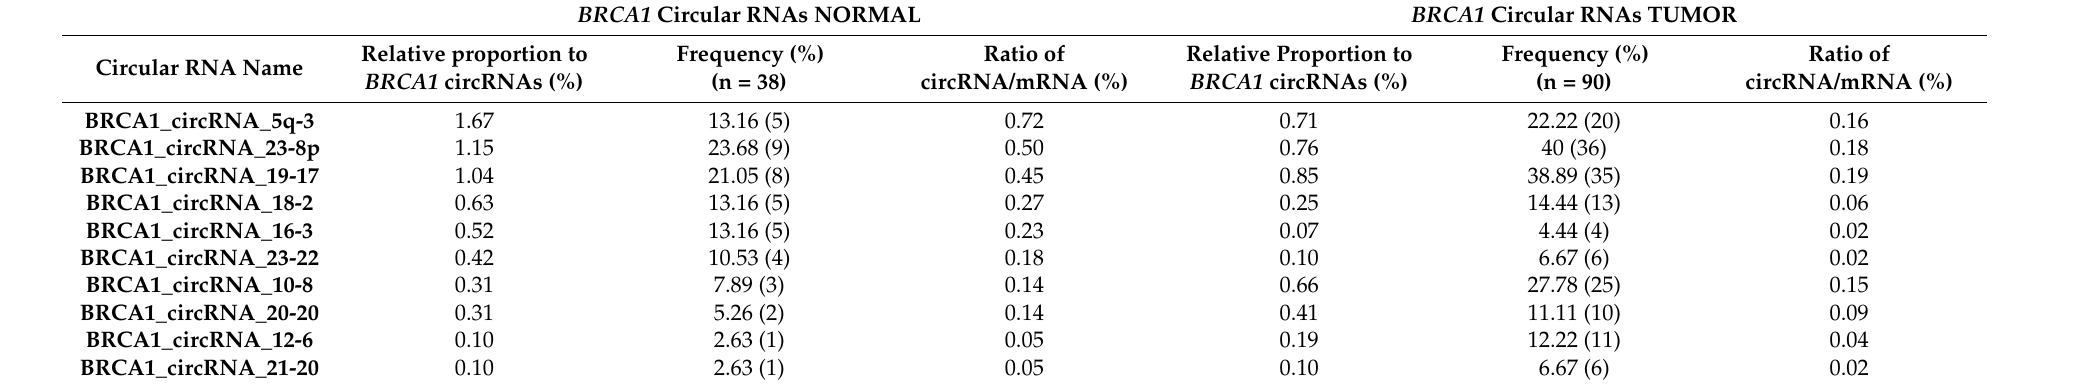
Table 3. Novel BRCA1 circular RNAs found in the normal and tumor breast tissue samples of the research set. BRCA1 Circular RNAs NORMAL